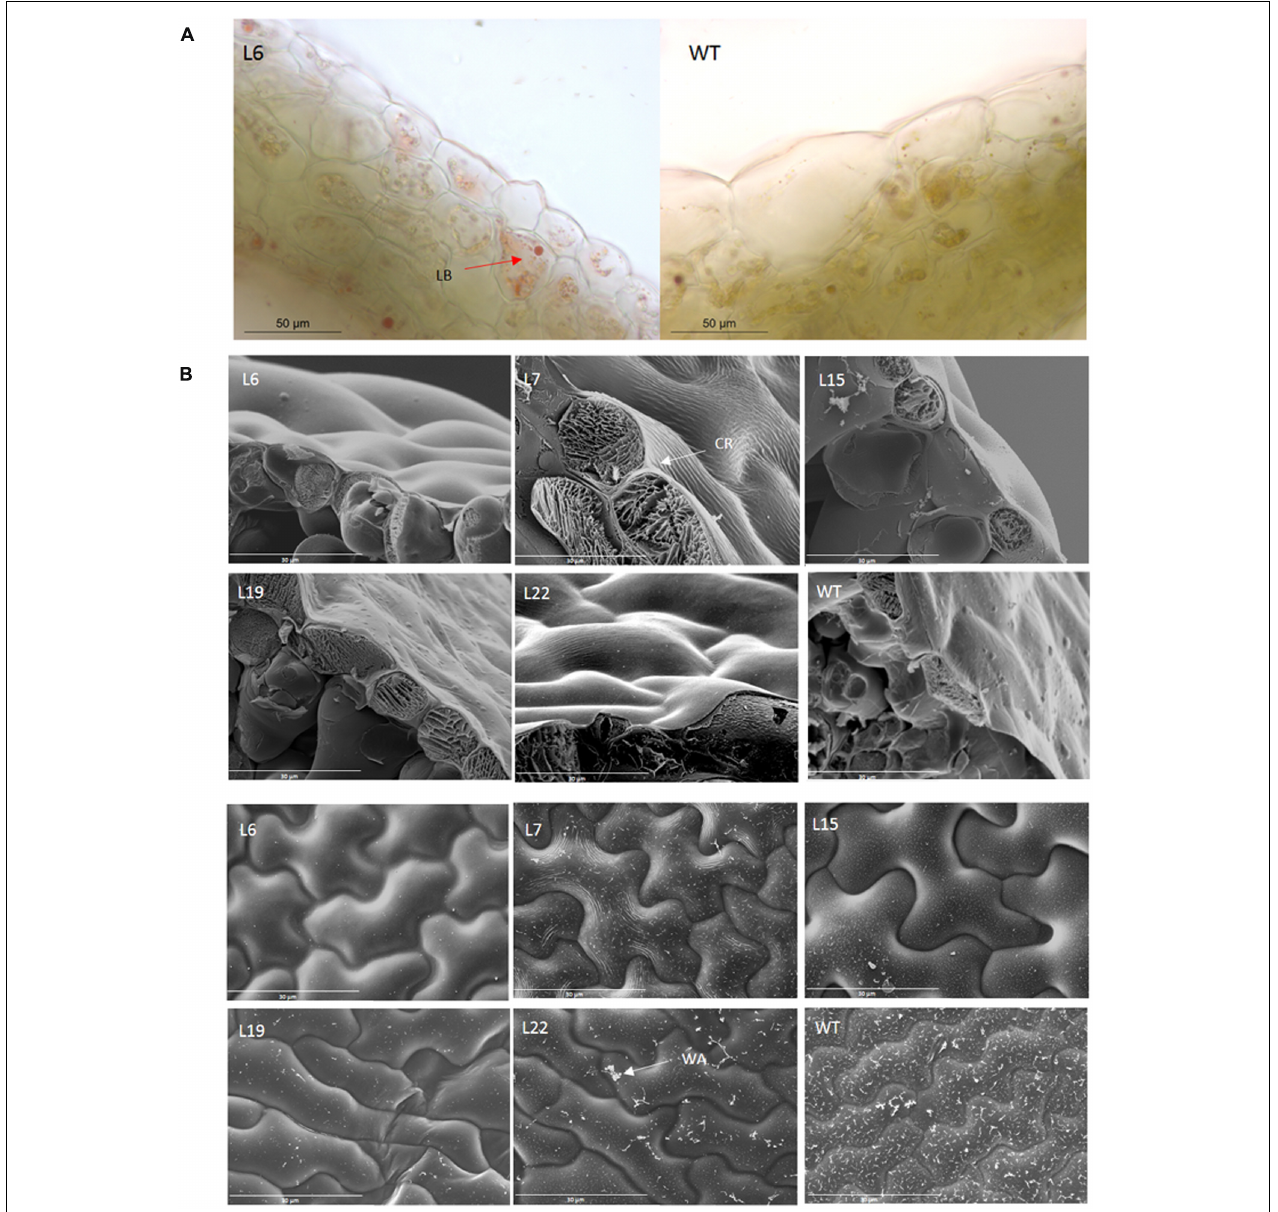
FIGURE 7 | Microscopic analysis of VviERF045 overexpressing lines. (A) Differences in lipids vesicle content in trangenic L6 and WT observed at 50X magnification and by SudanIV staining. LB, lipid bodies. (B) Changes in wax load and cuticle surface morphology of the transgenic lines detected by Scanning Electron Microscopy after freeze fracture (CryoSEM). Upper part: images of transversal section of the adaxial leaf surface. WT and L19 show wax deposition. (2000X) CR, Cuticular Ridge. Lower part: images of the adaxial leaf surface (1000X). WA, Wax Aggregates.